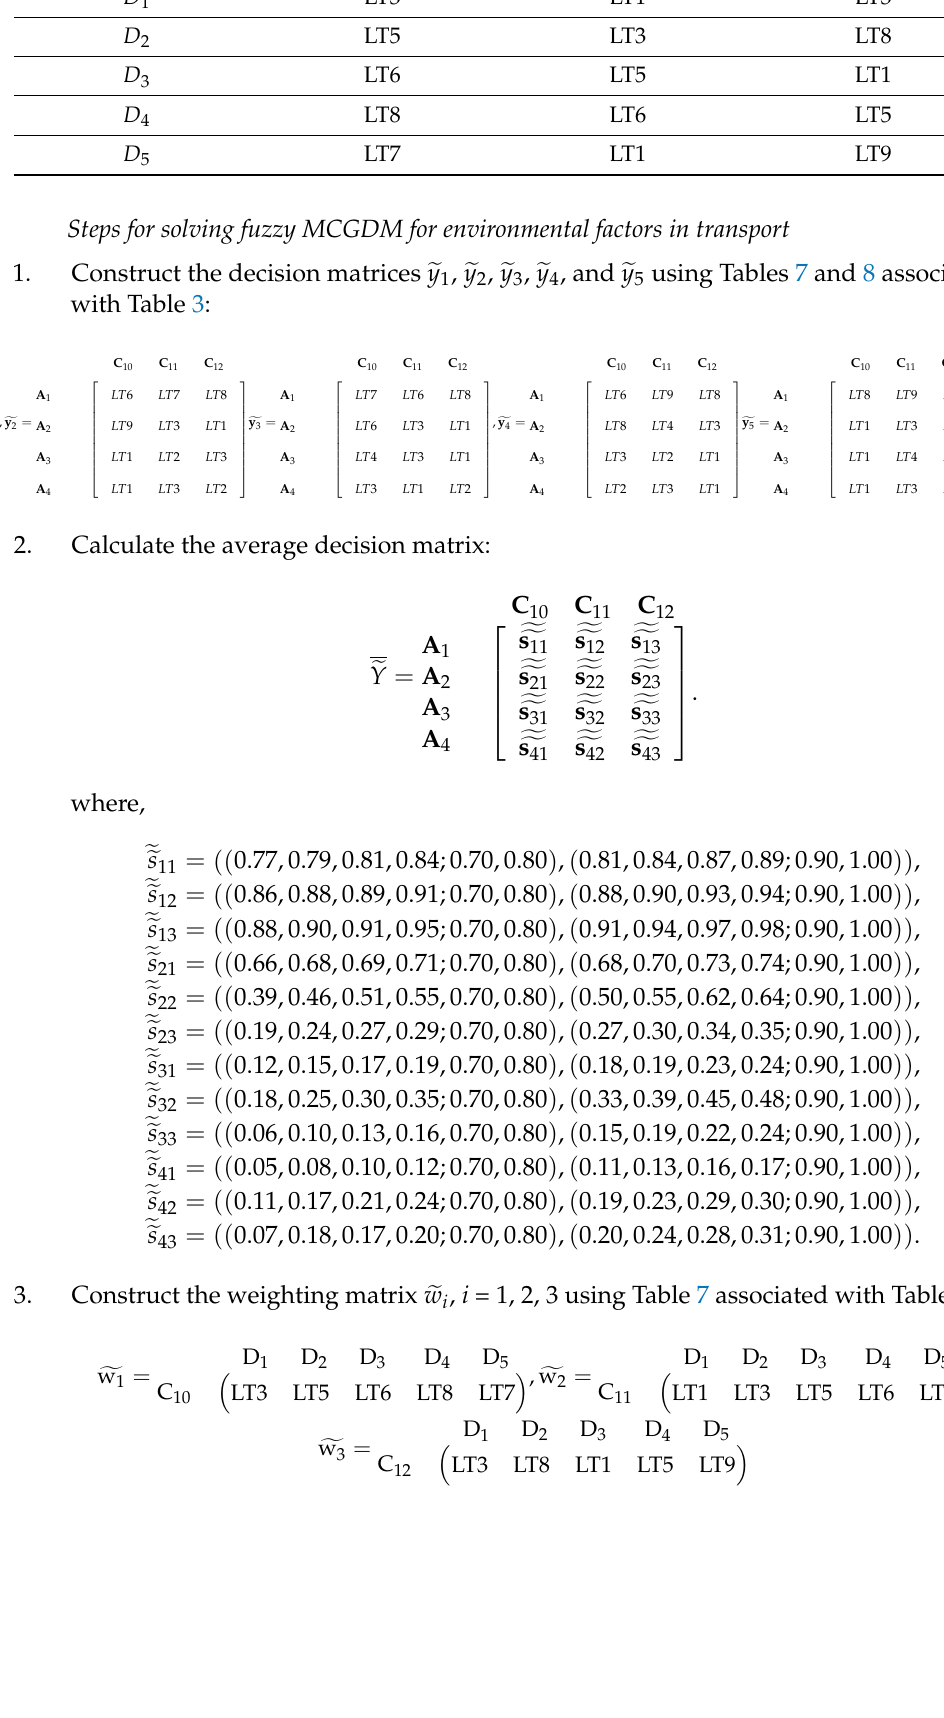
Table 8. Environmental factors weights of the criteria assessed by the decision-makers. Decision-Makers